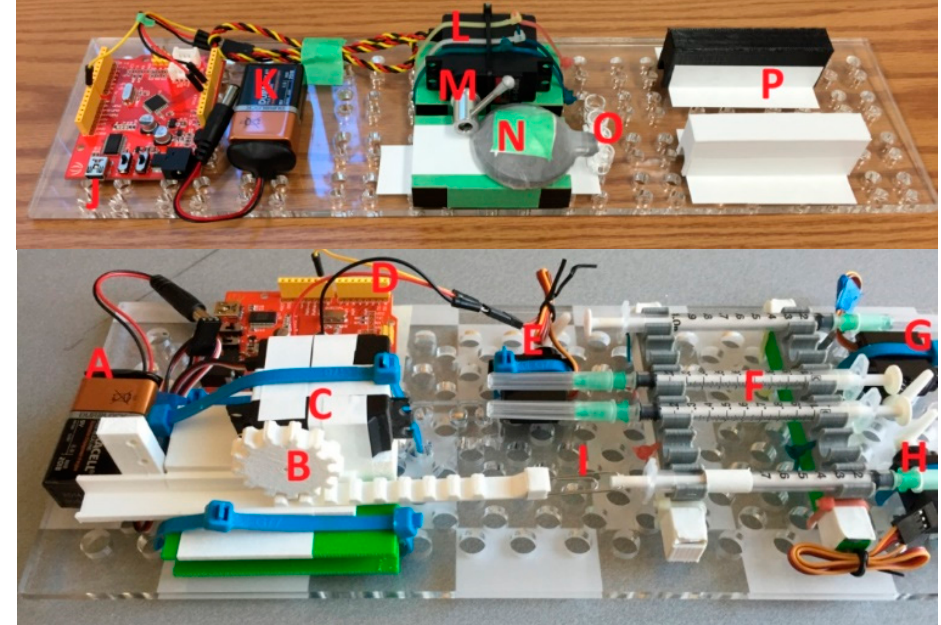
Figure 1. The automated bioassay platform is composed of two stackable boards: The bottom platform contains a battery (A), an aspiration syringe (I) connected via a printed rack-and-gear set (B) to the servomotor (C), which is controlled with an Arduino board (D) that also controls other servomotors (E, G, H) that push on syringes (F) with conjugate, substrate, and stop solutions. The syringes on the bottom board are connected via plastic tubes (4 mm outer diameter, 2 mm inner diameter) to the well (O) on the top platform, where another battery (K) and Arduino board (J) power and control the servomotor (L) that through arm (M), presses on an elastomeric dome (N) containing wash. The top platform also contains a printed frame (P) onto which a smart phone can be placed to detect color changes in the well.